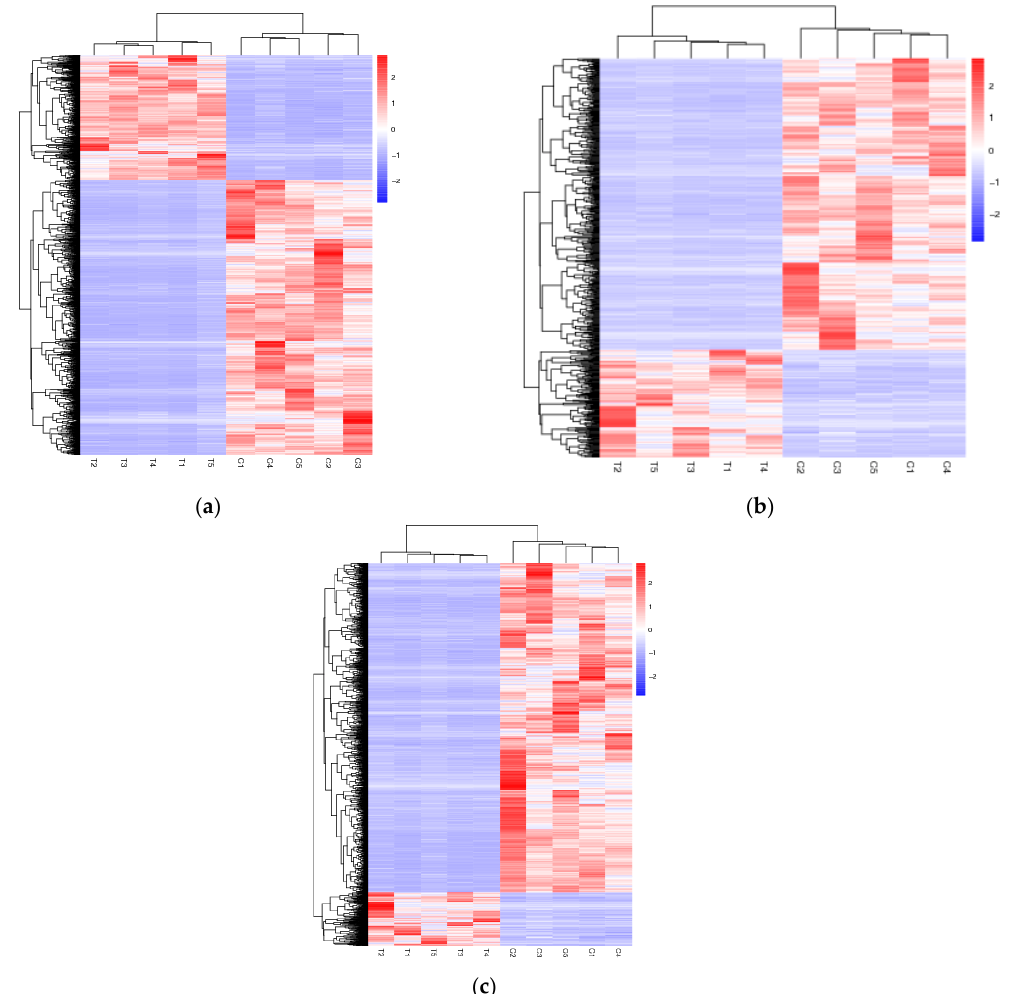
Figure 3. Heat maps of the distinguishable expression profiles between ‘lactating’ and non-‘lactating’ pigeon crops. ( a ) Hierarchical clustering of the differentially expressed mRNAs; ( b ) Hierarchical clustering of the differentially expressed known lncRNAs; ( c ) Hierarchical clustering of the differentially expressed novel lncRNAs. T1, T2, T3, T4 and T5 represent ‘lactating’ pigeons. C1, C2, C3, C4 and C5 represent non-‘lactating’ pigeons.